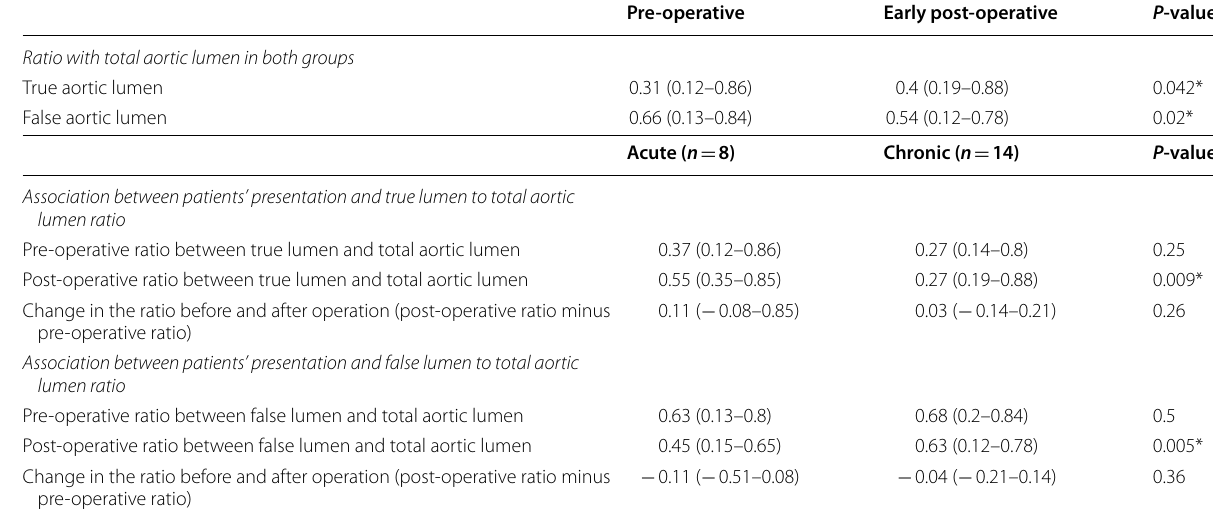
Data are represented as median